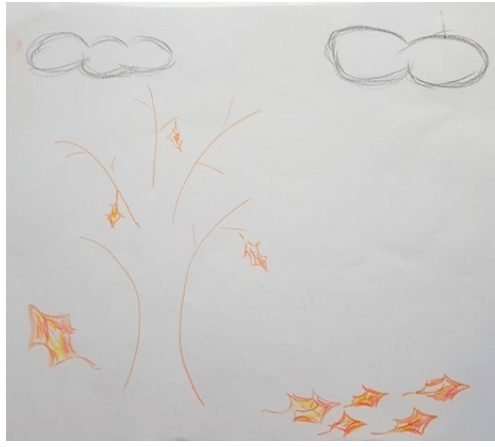
Figure 7. FC41’s perception of PD.